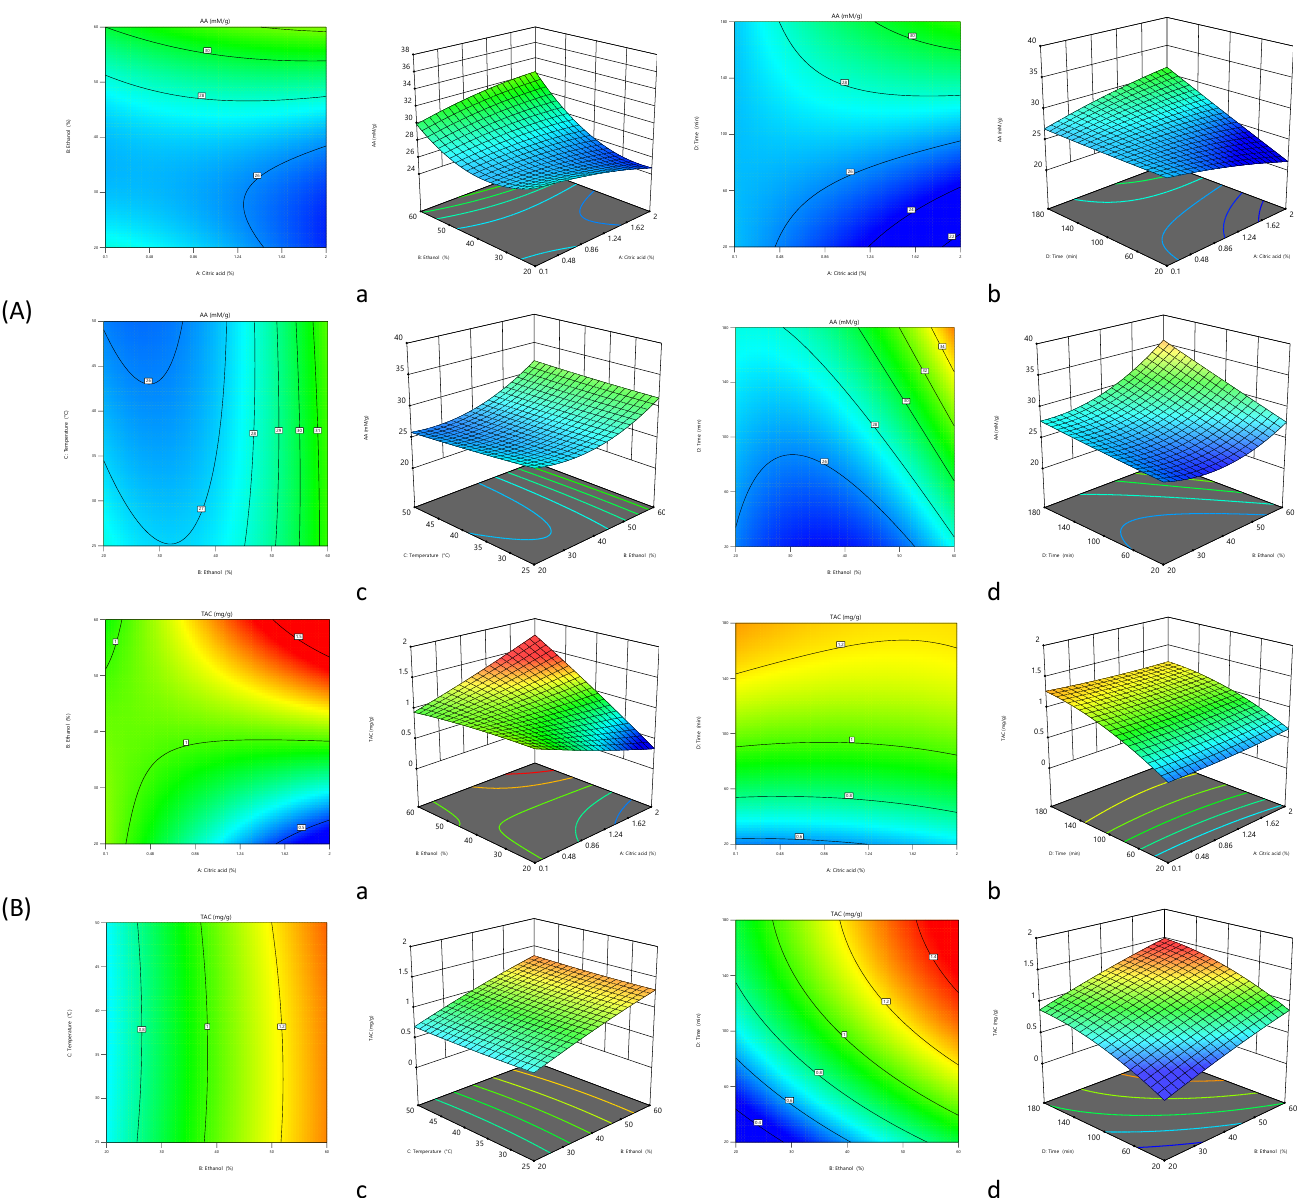
Figure 1. Second-order contour and 3D surface plots screening the variables’ effect on the antioxidant activity ( A ) and extraction yield of anthocyanins ( B